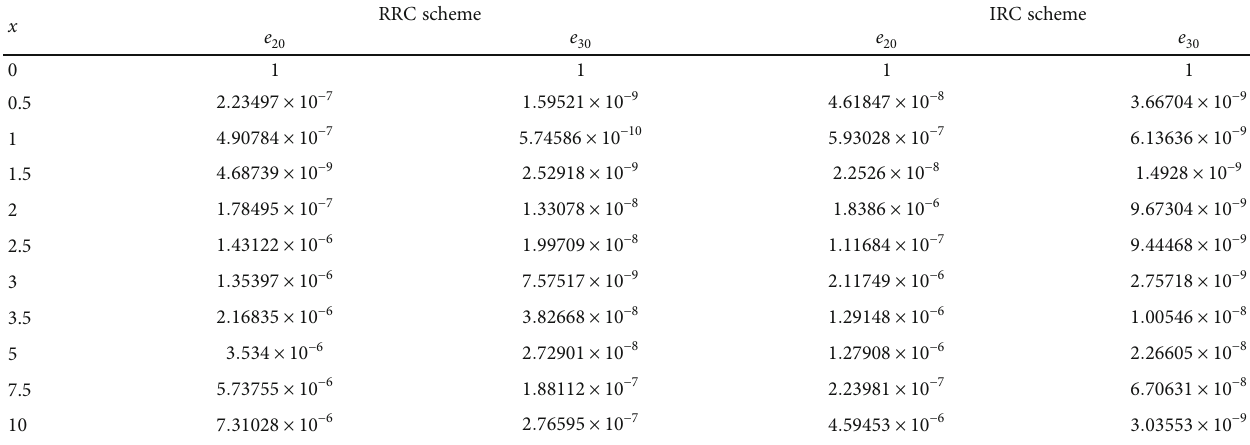
Table 2: Comparison between absolute errors with λ = 1 given by two proposed schemes.